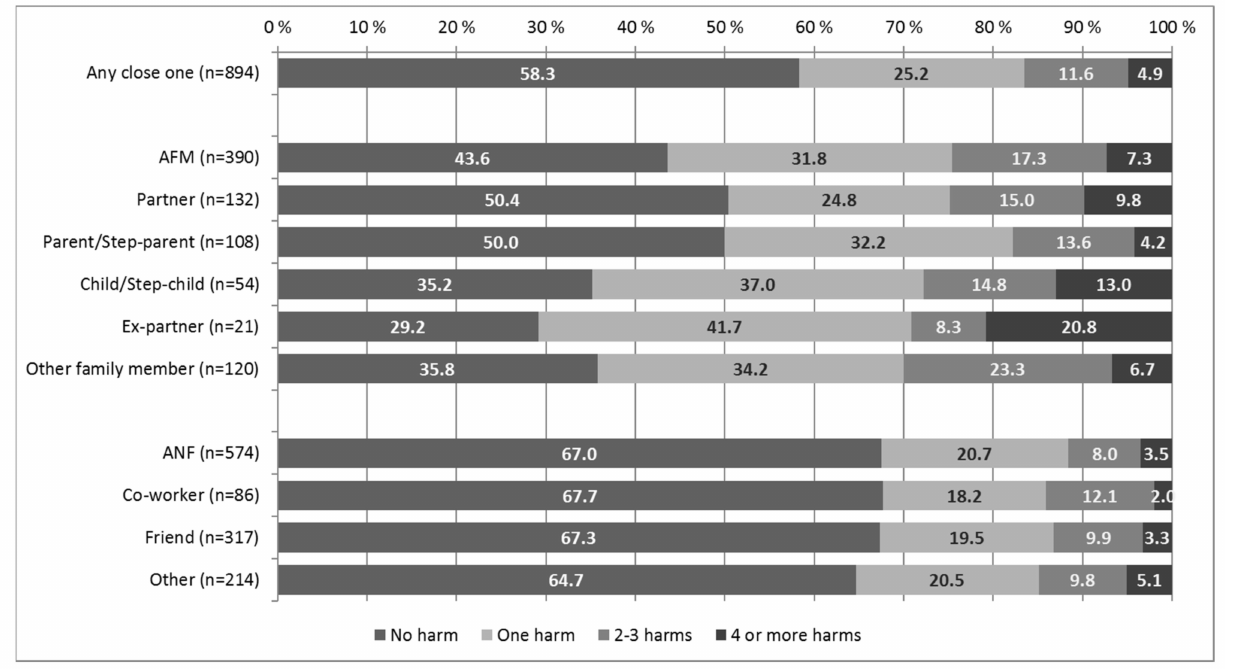
Figure 1. The amount of gambling harms for the AOs (n) by the problem gambler’s relationship to the AO. In addition, the data contained register-based information about the respondents’ gender and age. Age was dichotomized into two age groups: 18 − 34, and 35 and